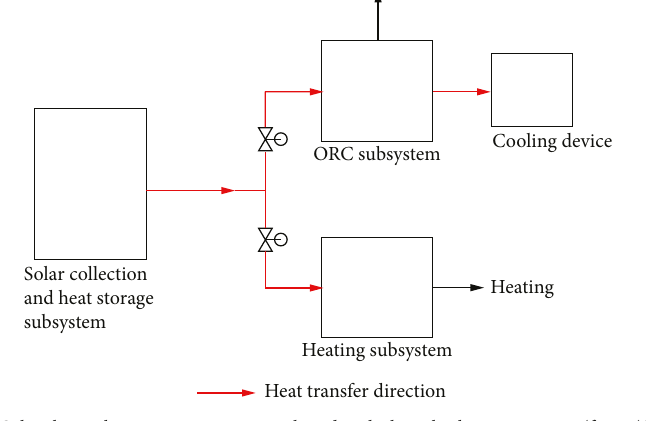
Figure 2: Forms when the building heating load is less than the e ff ective heat